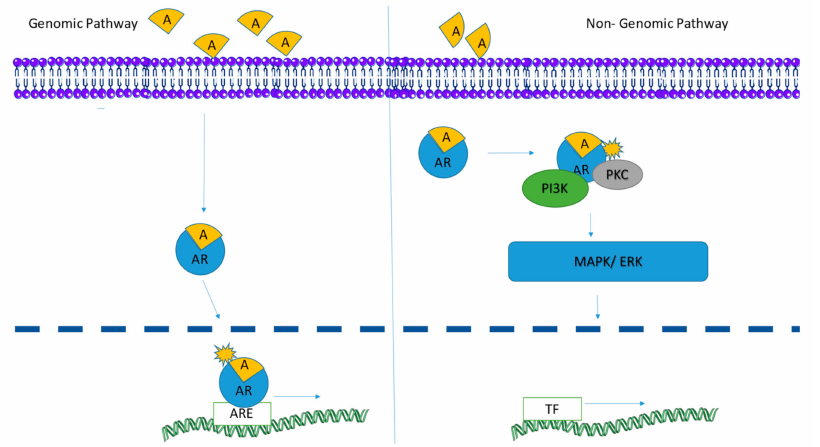
Figure 4. Schematic diagram showing the activation of the androgen receptor in both genomic and non-genomic pathways (after